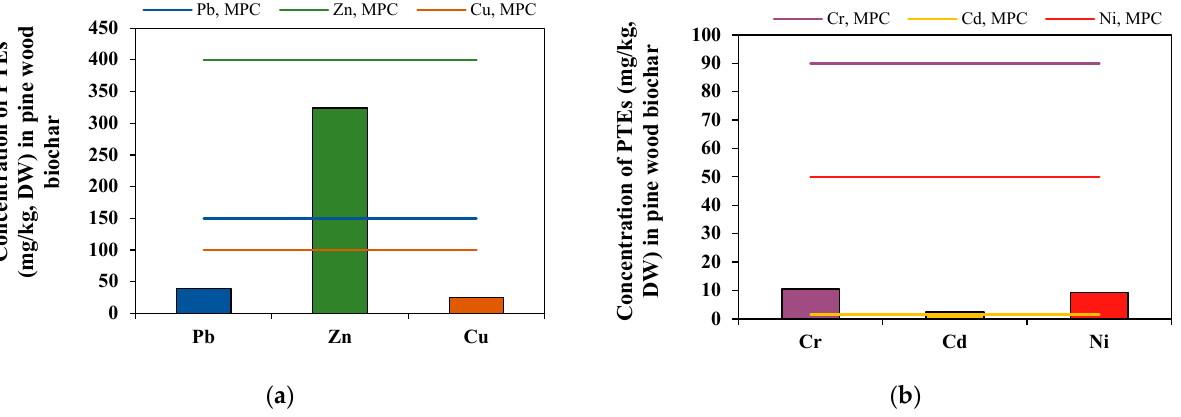
Figure 3. Concentrations of potentially toxic elements (mg/kg) in pine wood biochar: ( a ) lead (Pb),